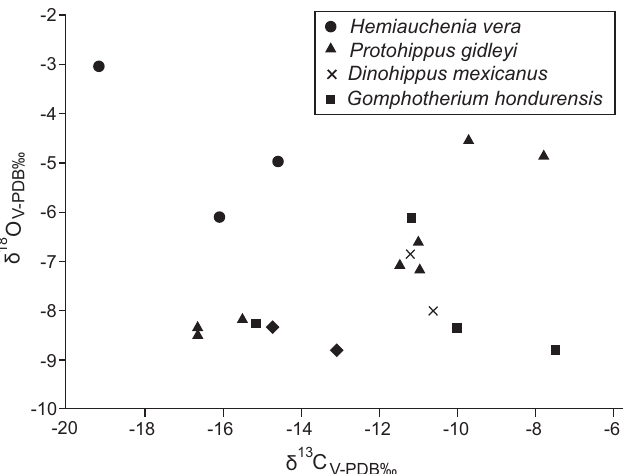
Fig. 3. Comparative analysis of carbon and oxygen stable isotope values in dental enamel from fossil herbivorous mammals of the San Gerardo de Limoncito